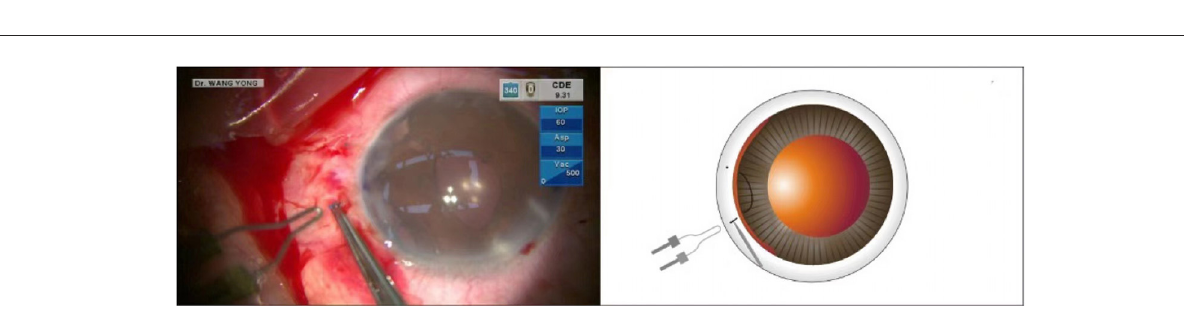
complications, such as hyphema, suture exposure, posterior synechia of the iris, or high intraocular pressure.